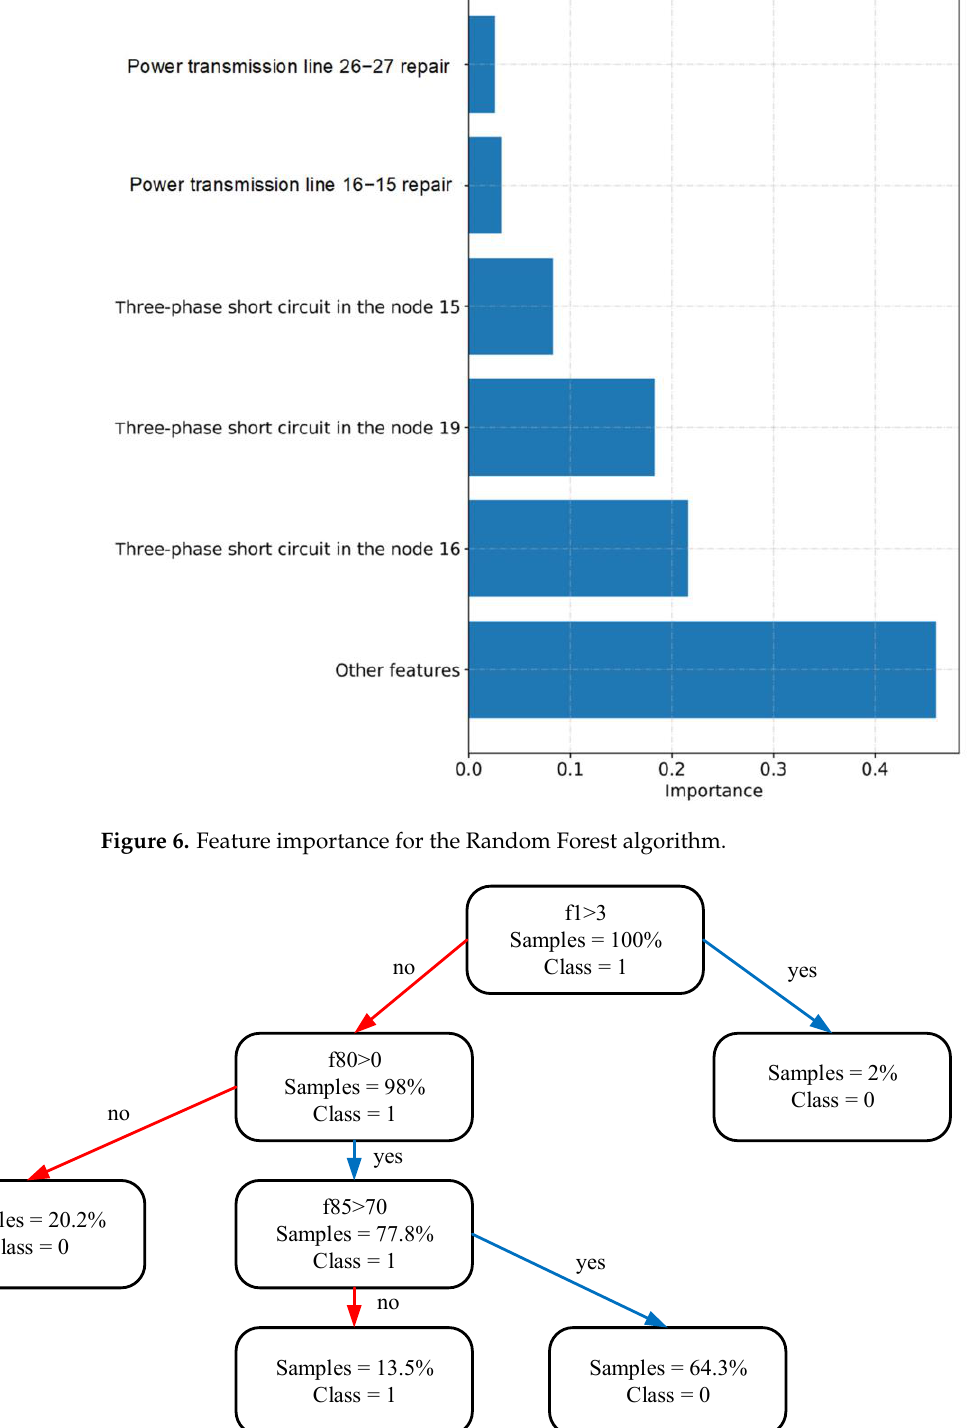
Figure 7. An example of one of the base classifiers of the Random Forest algorithm. The rules of data splitting in every node of the base classifier are defined in the process of the Random Forest algorithm learning.